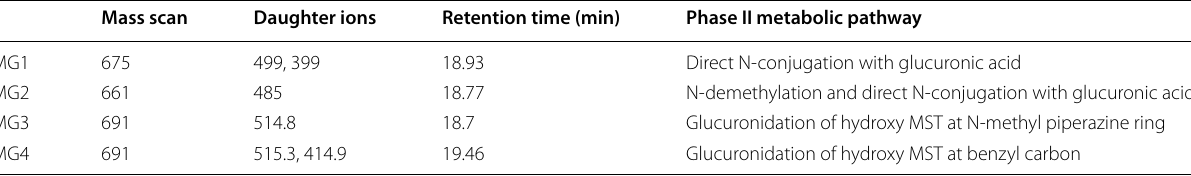
Table 4 In vivo phase II MST metabolites